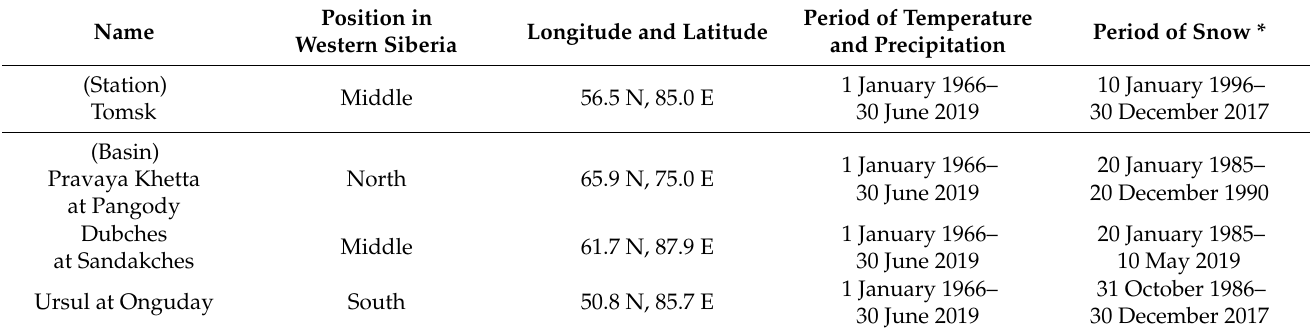
Table 1. Hydrometeorological data at Tomsk and three experimental